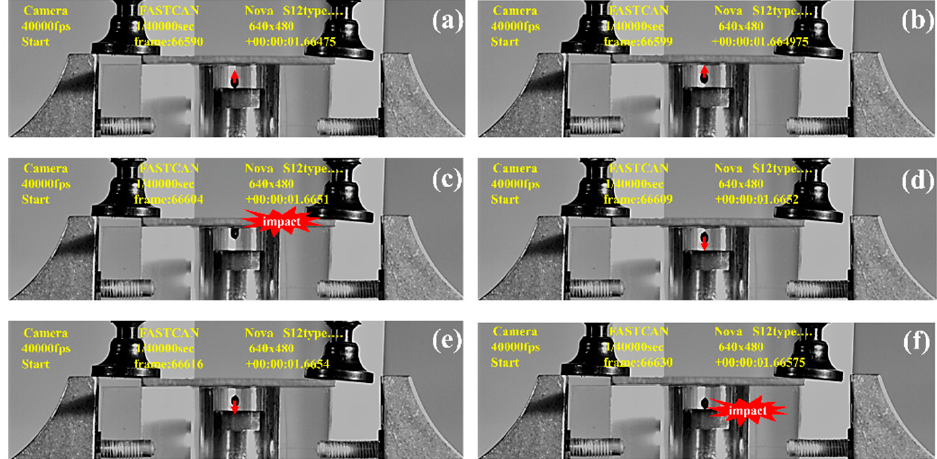
Figure 6. Observations of the motion behavior of a shot during the ultrasonic shot peening process using a high-speed camera with 40,000 fps: ( a ) is the initial state of a shot; ( b ) shows a shot moving toward the target surface; ( c ) is an impact between the shot and the target surface; ( d ) shows the shot rebound back to the surface of the tip after the impact; ( e ) shows the shot moving toward the vibrating surface; and ( f ) shows the impact between the shot and the vibrating surface.